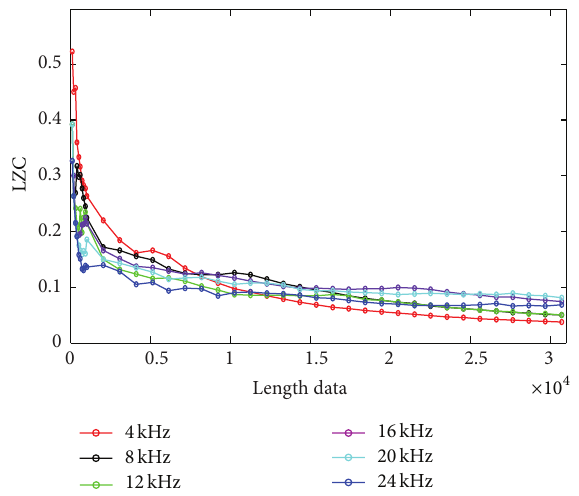
Figure 8: The calculated LZC values by different parameters (length of the data and the sample frequency).